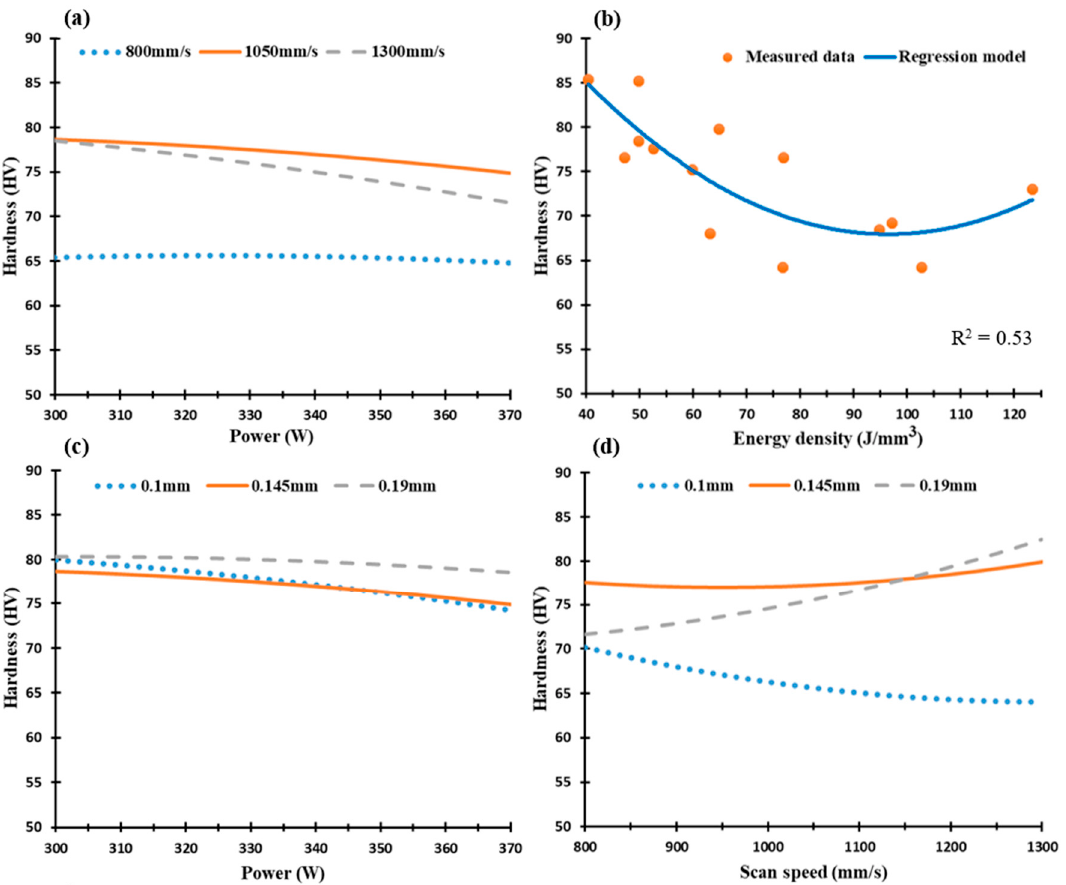
Figure 12. Microhardness of the as-built Al6061 samples along the Z-direction vs. ( a ) Laser power (W); ( b ) Energy density (J/mm 3 ), ( c ) Hatch Spacing (mm), and ( d ) Scan speed (mm/s).